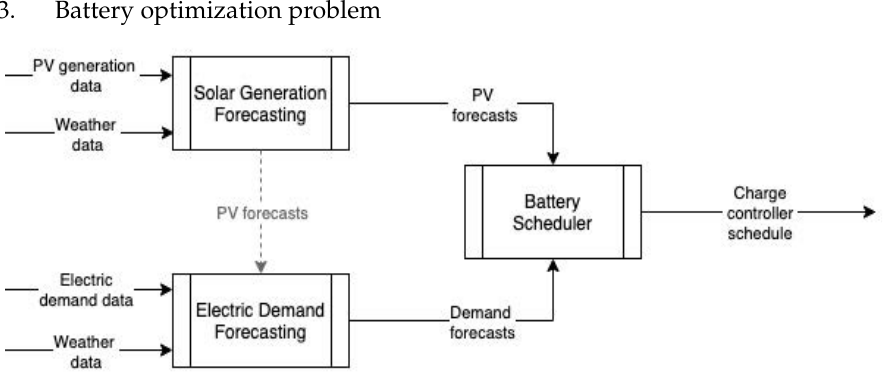
Figure 1. Architectural design of the proposed approach.